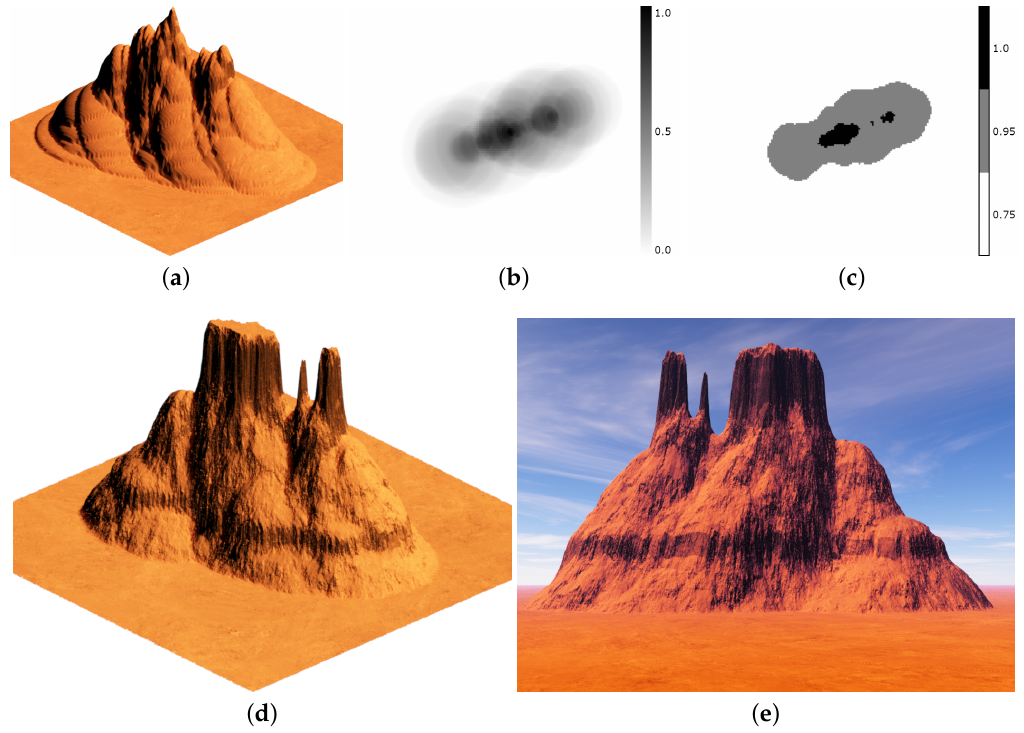
Figure 19. Textured and rendered in a Terragen butte-like asset obtained by the proposed method (grid resolution: 150 × 150, fault radius: 1 (cid:54) r (cid:54) 35; total faults: 35 along x-axis). The model consists of 3 materials with following hardness [ 0.75; 0.95; 1.0 ] . Erosive model was obtained for E = 0.35 with caprock and (cid:36) = 1. The object feature is similar to the Mittens buttes natural formation in Figure 2b. ( a ) Plain initial model obtained by the CFF method. ( b ) Initial map of the model for material classifier. ( c ) Material layer and hardness records. ( d ) Orthographic view of the asset. ( e ) Perspective view of the asset in a virtual